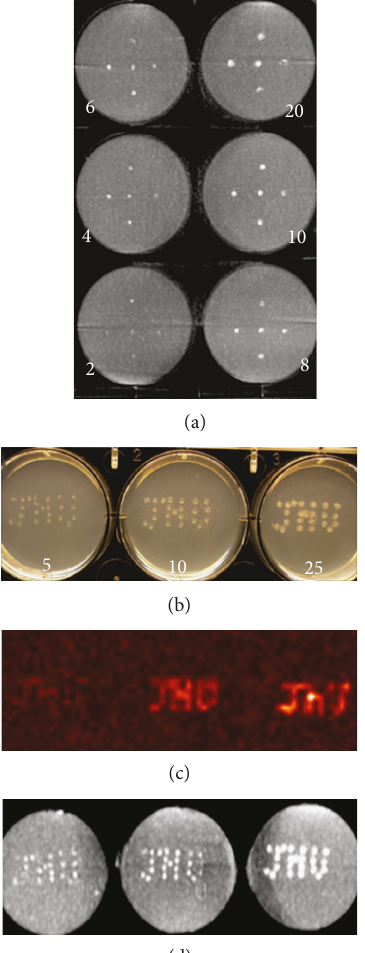
Figure 3: C-arm CT and 19 F MR images of PFOBCap phantoms. (a) Maximum intensity projection (MIP) of C-arm CT image of a PFOBCap phantom containing 2, 4, 6, 8, 10, or 20 PFOBCaps/dot (number in white) arranged in fi ve locations per well. As few as two PFOBCaps are readily seen in C-arm CT image. (b) A digital photograph of PFOBCap phantom with 5, 10, or 25 PFOBCaps/dot arranged in “ JHU ” pattern. (c) 19 F MRI of PFOBCap phantom shows the detectability of as few as 10 PFOBCaps within less than 2min acquisition time. (d) MIP of C-arm CT image of the same PFOBCap phantom as (a) showing the detection of all PFOBCaps.